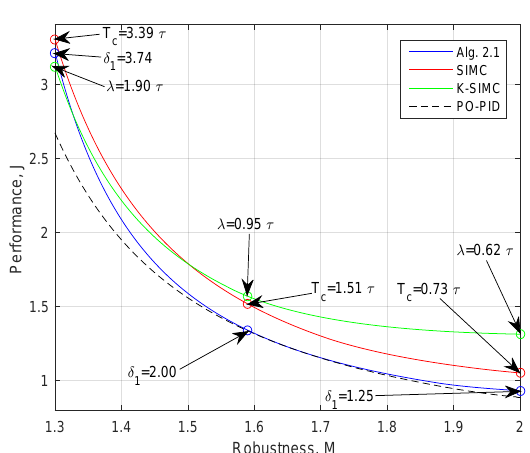
Figure 4: Example 3.1: Performance vs. robustness, J vs. M s trade-off curves. Comparing Alg. 2.1, SIMC and K-SIMC vs. the PO-PID con-